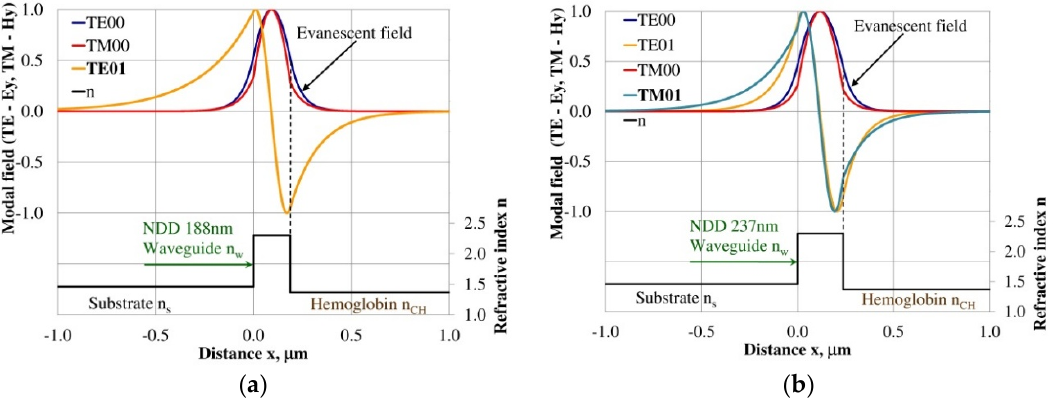
Figure 6. Modal field distribution in the multi-mode NDD-based waveguide: ( a ) TE01 for maximum dN eff /dn cH and ( b ) TM01 for maximum dN eff /dn cH .